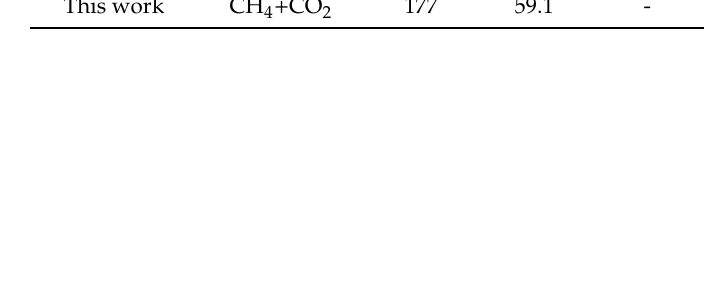
Table 1. Comparison of H 2 production rates and energy yields for various plasma-based methods. This work CH 4 + CO 2